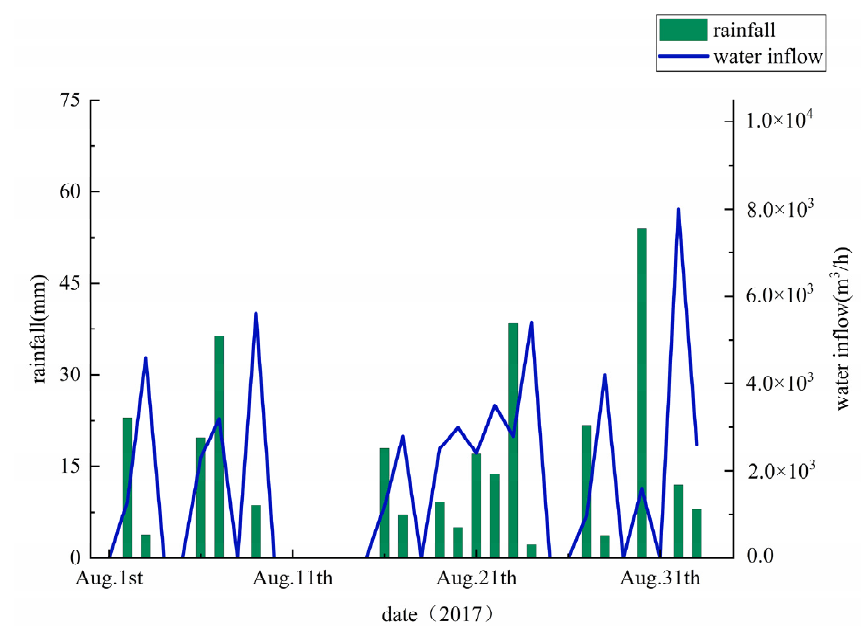
Figure 9. Rainfall monitoring—water inflow in the tunnel.